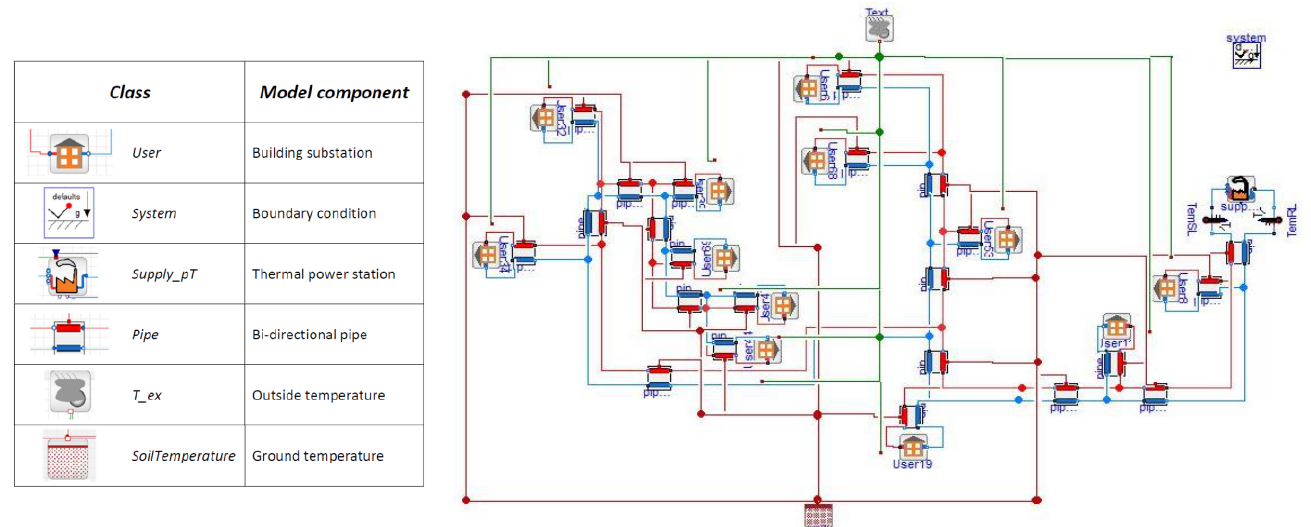
Figure 2. Diagram view of the “Nuova Sud” district dynamic model in Dymola.